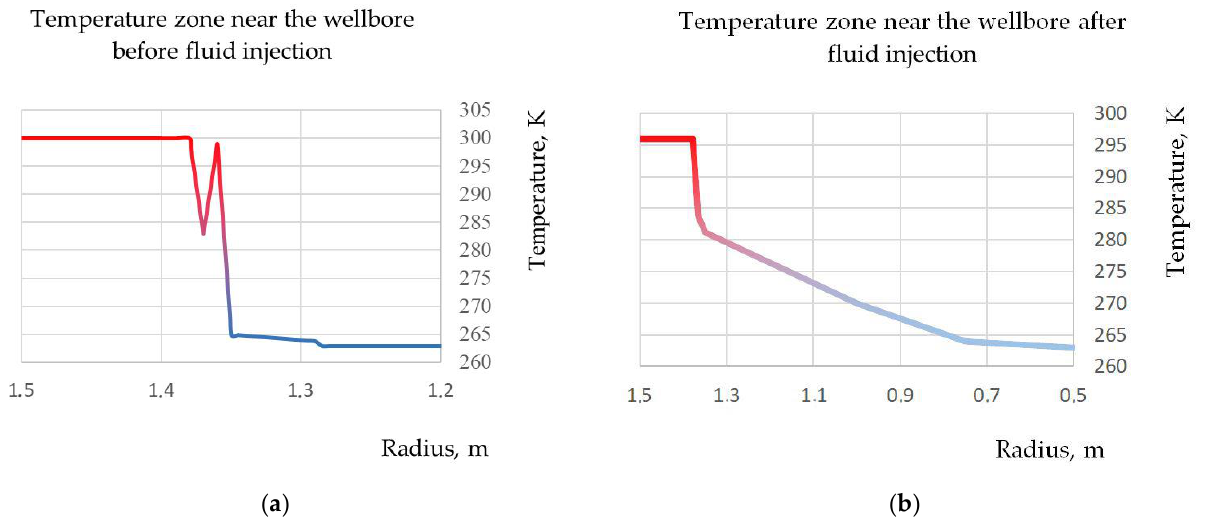
Figure 3. Temperature zone near the wellbore before and after fluid injection: ( a ) — temperature zone near the wellbore before fluid injection; ( b ) — temperature zone near the wellbore after fluid injection.